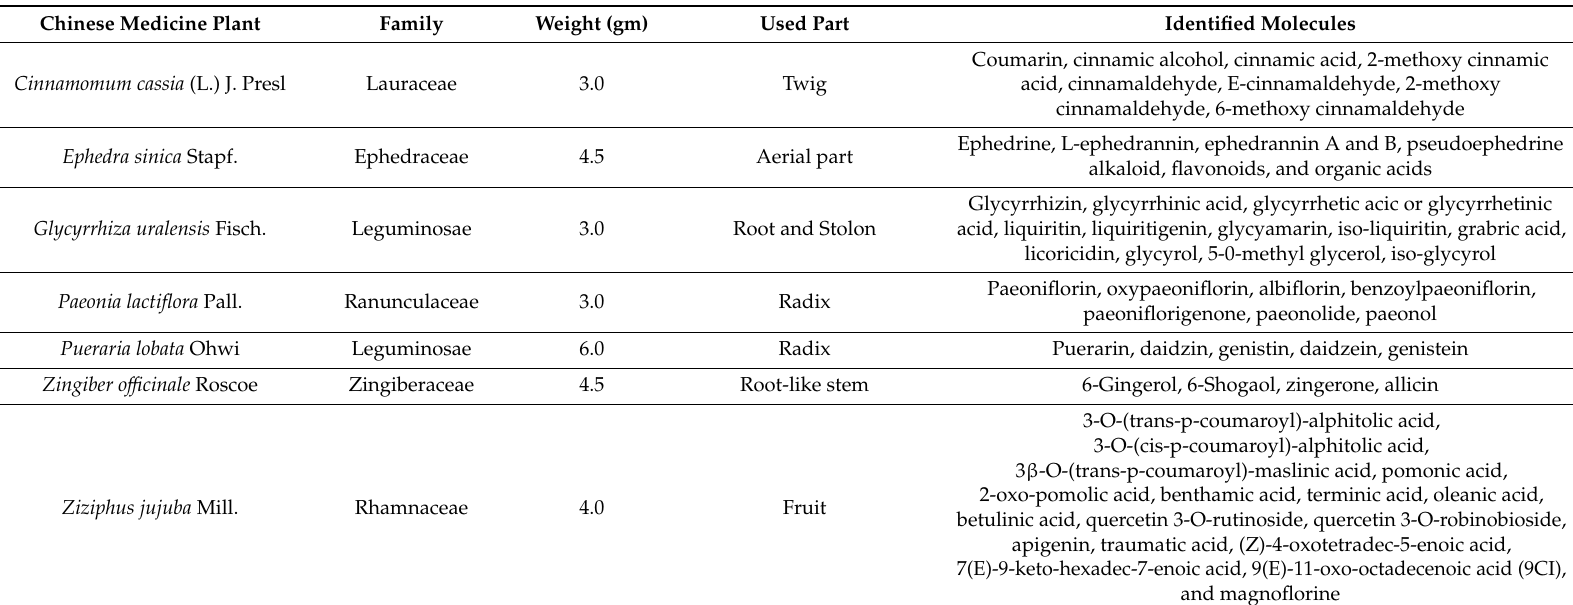
Table 1. Composition of Ge-Gen-Tang (GGT; Kakkon-to in Japan; Galgeun-tang in Korea; Ge-Gen-Tang in Chinese)